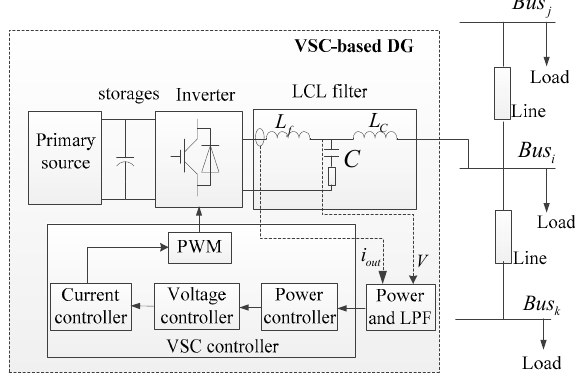
Figure 1. Typical structure of a VSC-based DG.